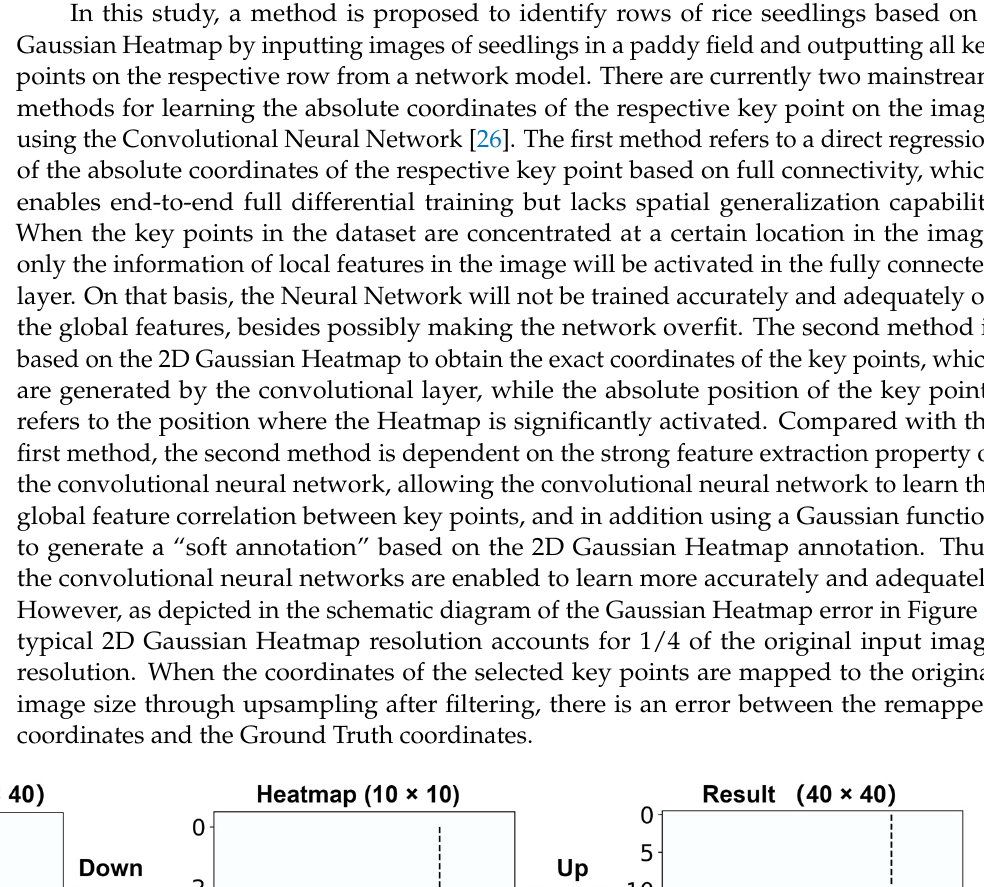
Figure 5. Schematic diagram of Gaussian Heatmap and Grid Offset Module. In order to improve the accuracy of the model prediction results while preventing the problem of disappearance or explosion of the gradient as the model reaches deeper layers, we use HRNet_w18 [27] as the backbone feature extraction network of the model in this study. As showed in Figure 6 of Network Model, the HRNet_w18 backbone feature extraction network comprises the Stem Net Module, the Basic Conv Module, as well as the High-Resolution Convolution Module. To be specific, (1) the Stem Net Module and Basic Conv Module perform high-resolution feature extraction on the input image. (2) The High-Resolution Convolution Module strengthens and extracts the feature layers; its core function is to use convolution and stacking at multiple resolutions to keep the input fea- tures significantly activated at different resolutions during the forward inference of the